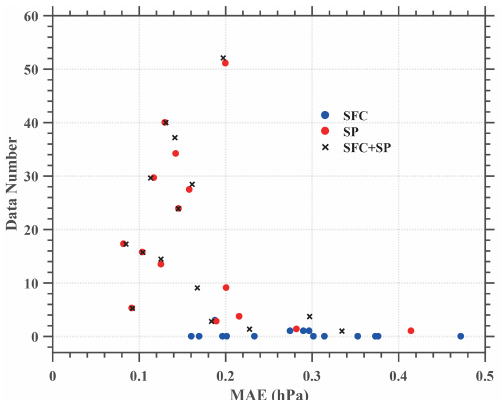
Figure 17. Scatter plot of mean absolute error (MAE) versus ob- servation number within 10km and 5min of the verifying weather station. The blue dots stand for the station observation experiment (SFC), red dots represent the smartphone experiment (SP), and the station observation plus smartphone experiment (SFC + SP) is shown as black